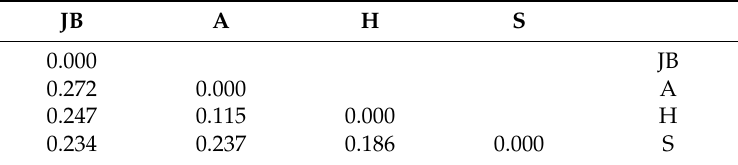
Table 4. Genetic distance of Nei (1978) [29] among provenances of A. spinosa.